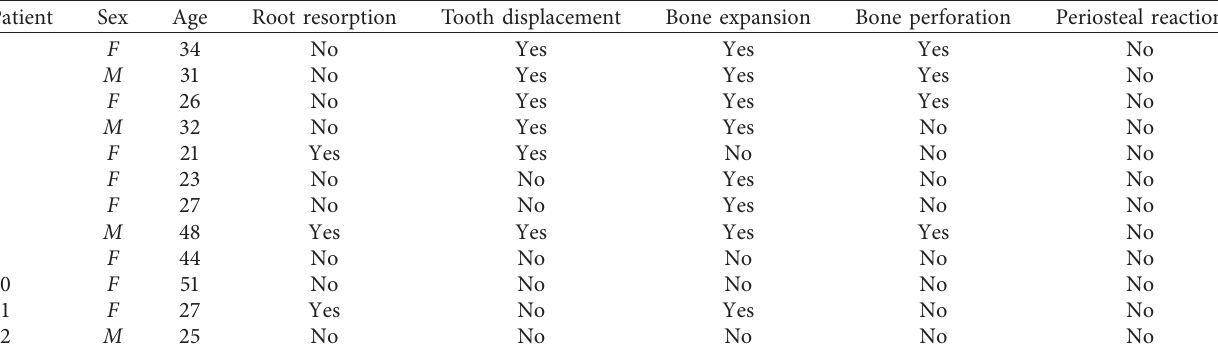
Table 2: Radiographic features of 12 patients with central odontogenic myxoma—root resorption, tooth displacement, bone expansion, bone perforation, and periosteal